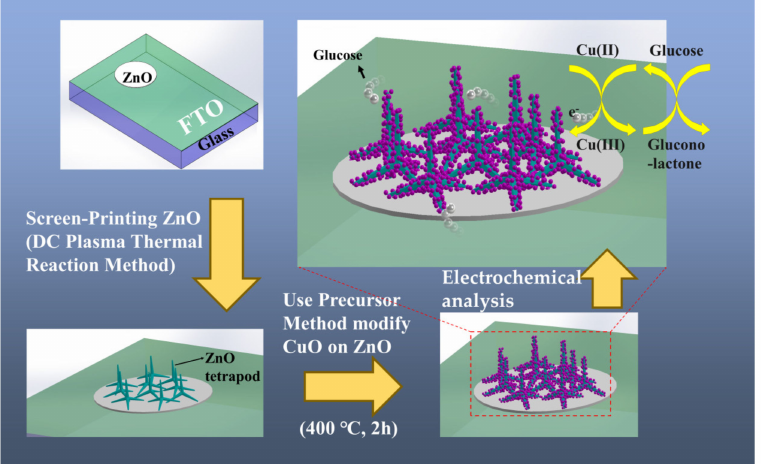
Scheme 1. Schematic illustration of the synthesis of a non-enzymatic glucose sensor